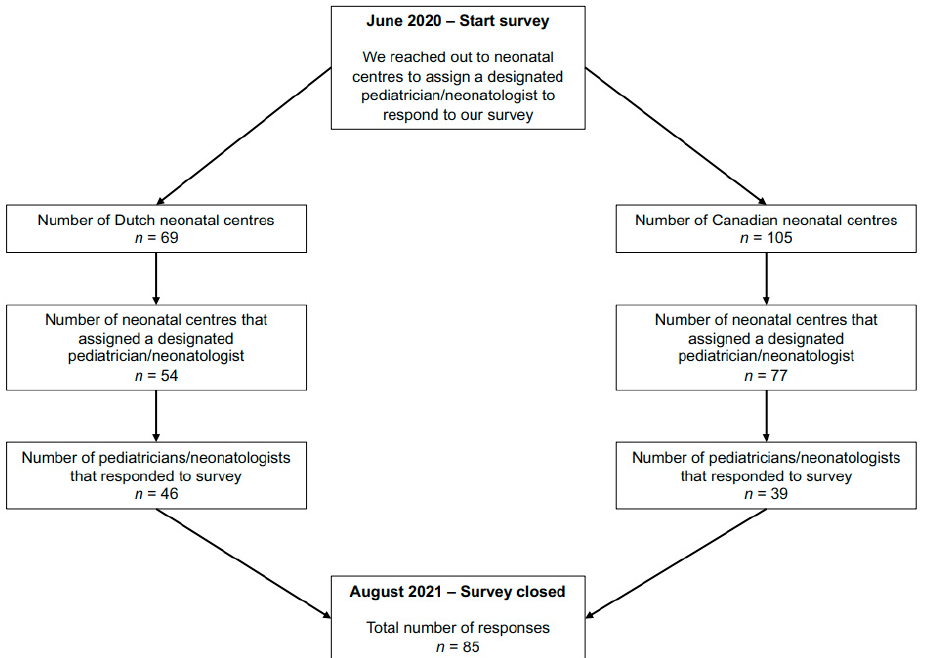
Figure 1. Recruitment of participants. Table 1. Characteristics of participants and setting.